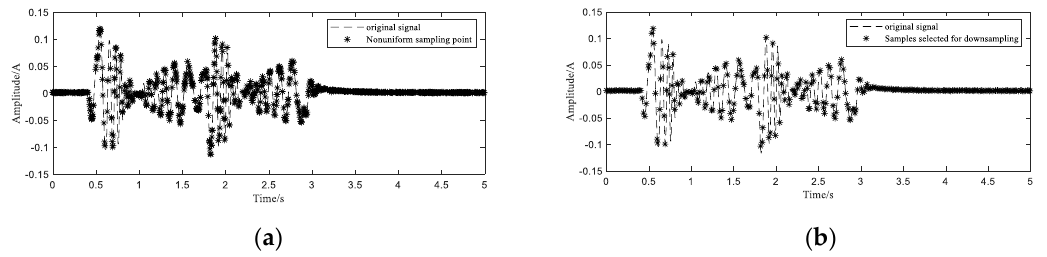
Figure 12. Reorganization of sampling points ( a ) and screening of sampling points ( b ).